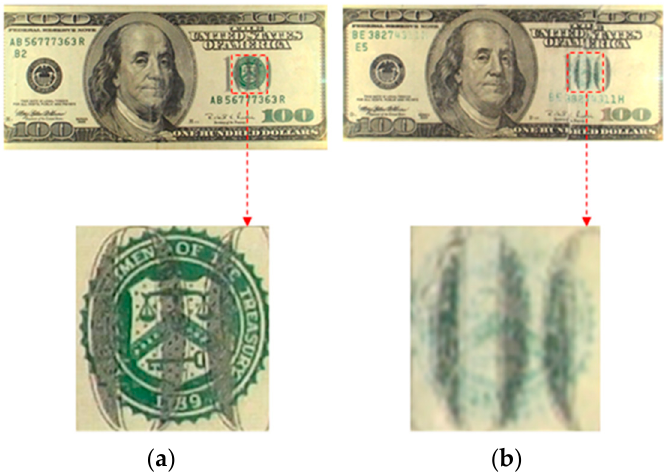
Figure 1. Example of genuine and counterfeit banknotes (USD 100 bill): ( a ) a genuine banknote; ( b ) a counterfeit banknote.